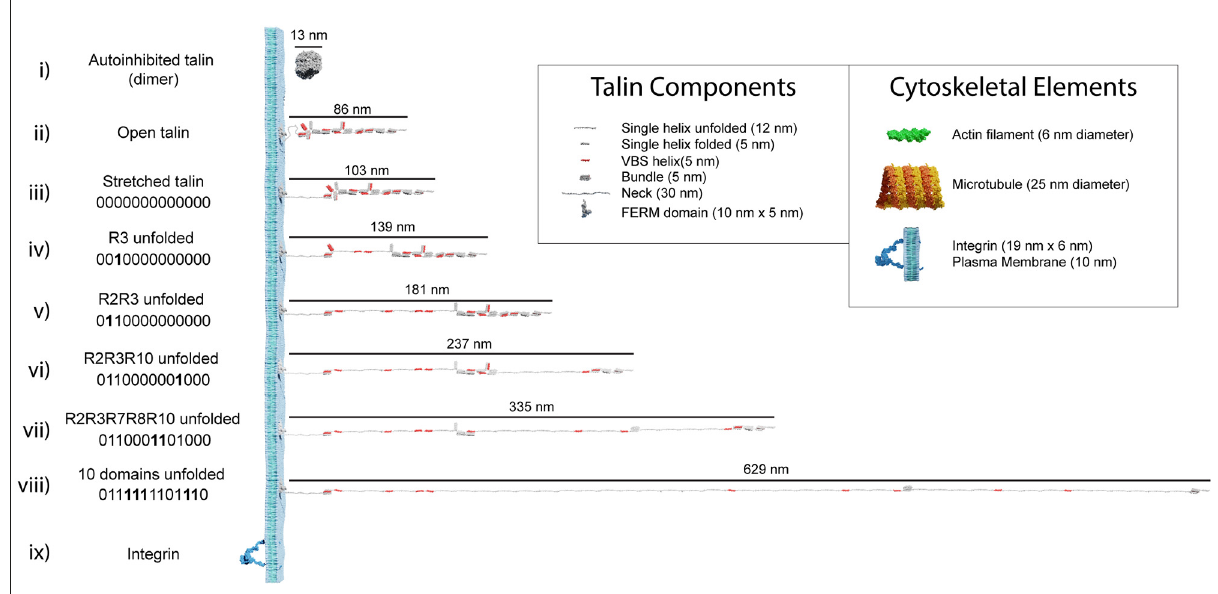
FIGURE3 Talin to scale. Scale models of talin in different conformations. The length of each form is shown in nanometres. The binary string represented by each state is shown, with 0000000000000 representing the fully folded state and 1111111111111 the fully open state. In each subsequent binary string, the changing switch is indicated in bold. (i–iii) Three representations of fully 0-state talin, (i) the autoinhibited dimeric form of talin (Goult et al., 2013a), the autoinhibited monomeric form (Dedden et al., 2019) is slightly smaller. (ii) Open talin, the same as in Figure 2A is ∼ 86 nm in length. (iii) As talin experiences tension, the linker can extend so the molecule is ∼ 103 nm. (iv) As force is exerted on talin, the R3 switch opens first, exposing two VBS, and the length of the molecule increases by 36 nm if both VBS bind vinculin, or 47 nm otherwise. (v-viii) As additional domains unfold, the binary patterns change and the length of the molecule undergoes stepwise changes in length, ranging from 86 to 760 nm whilst still maintaining a mechanical linkage. Only 10 domains are shown unfolded in, (viii) but 12 can unfold and still maintain the mechanical linkage to actin via R13. We note that it is possible for all 13 switches to unfold and still maintain a mechanical linkage at the C-termini via the VBS in R13. The fully 1-state talin is not shown as its length would exceed the page width. (ix) Remarkably, integrins are relatively small in comparison, here an active integrin heterodimer is shown on the same scale. Inset: The dimensions of the different talin components. Major cytoskeletal elements including integrin/plasma membrane, actin filaments, and microtubules are shown for comparison. The integrin cytoplasmic tails which talin connects to extend ∼ 10–15